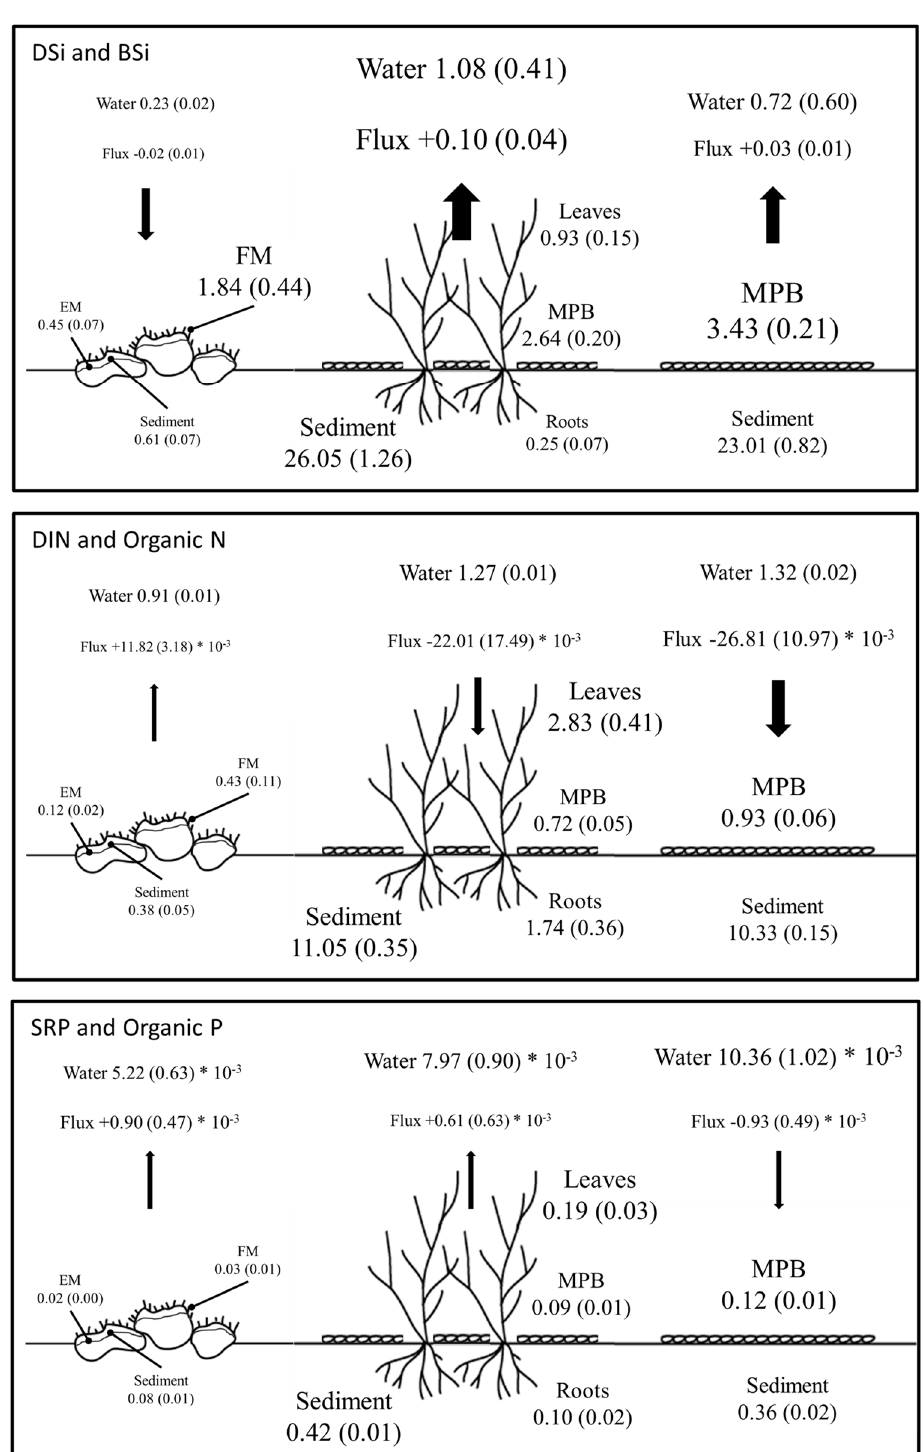
Figure 6. Average water column concentrations, main fluxes, and compartments of Si, N, and P. Fluxes are reported as g m − 2 d − 1 , while water concentrations, sediment, microphytobenthos (MPB), epilithic matter (EM), filamentous matter (FM), leaves and roots contents are reported as g m − 2 . Standard error is shown in parenthesis. The size of numbers and letters is proportional to flux and stock extent.